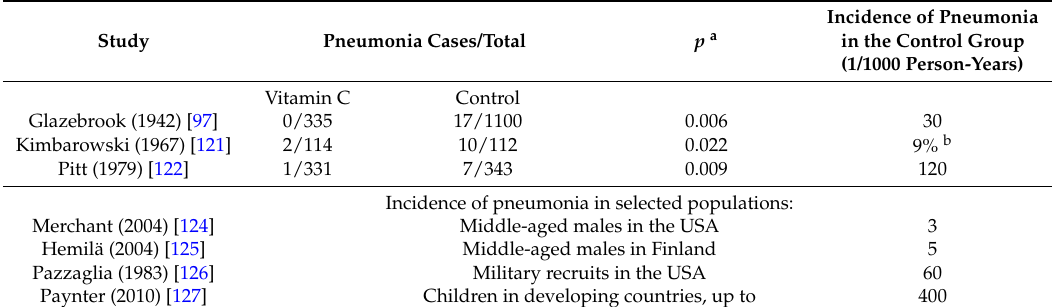
Table 7. Effect of vitamin C on the incidence of